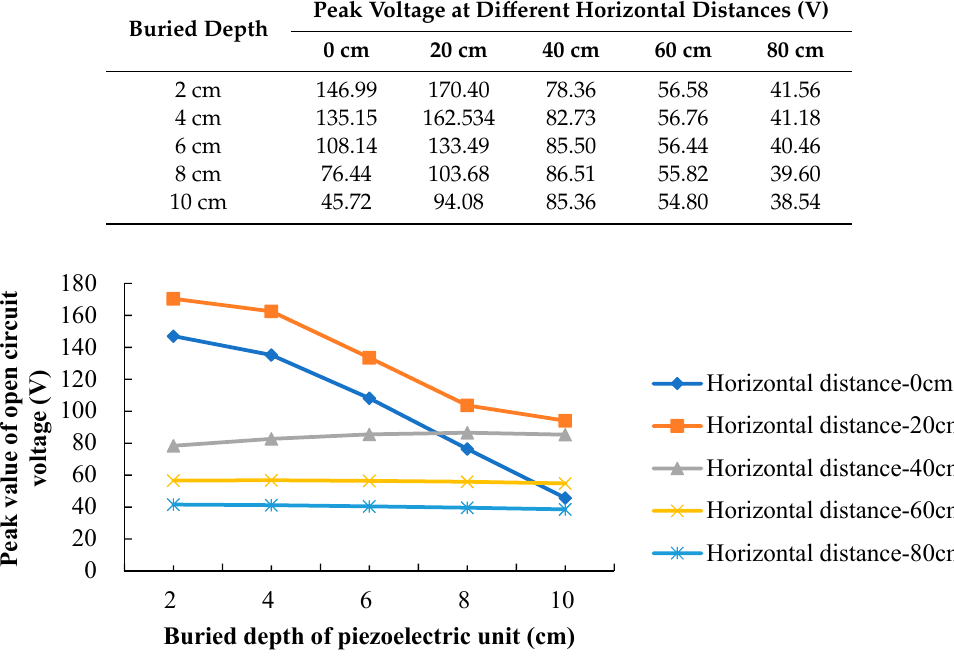
Figure 6. Response of PEH at di ff erent buried depths with di ff erent horizontal loading distances.